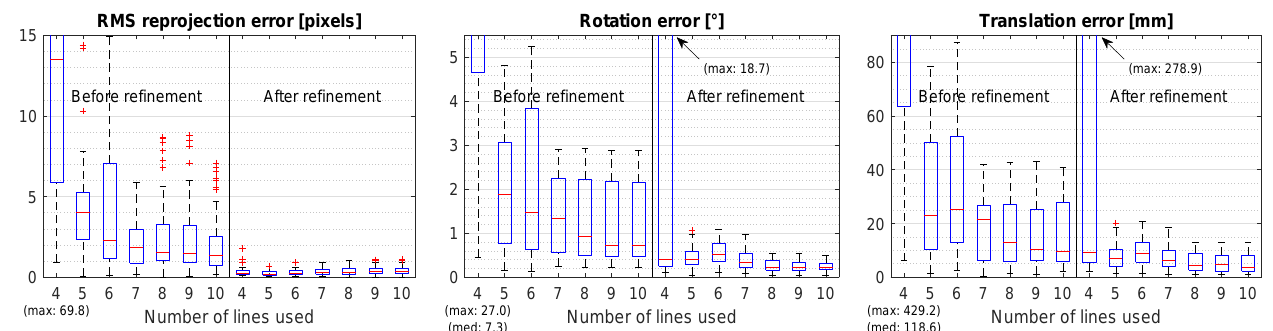
Figure 12. Box plots of the results with the translation stage as ground truth. The first row shows the results before refinement and the second row shows the results after refinement. The calibration errors with four lines are not fully visible because they are so much larger than the rest. Missing maximum and median values are shown in